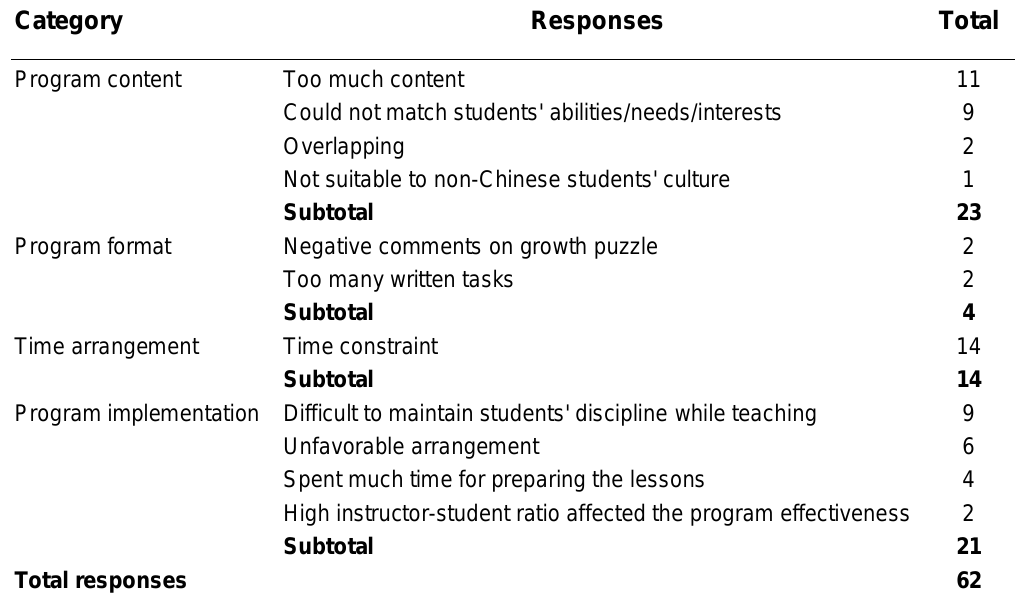
Responses on Difficulties Encountered during Program